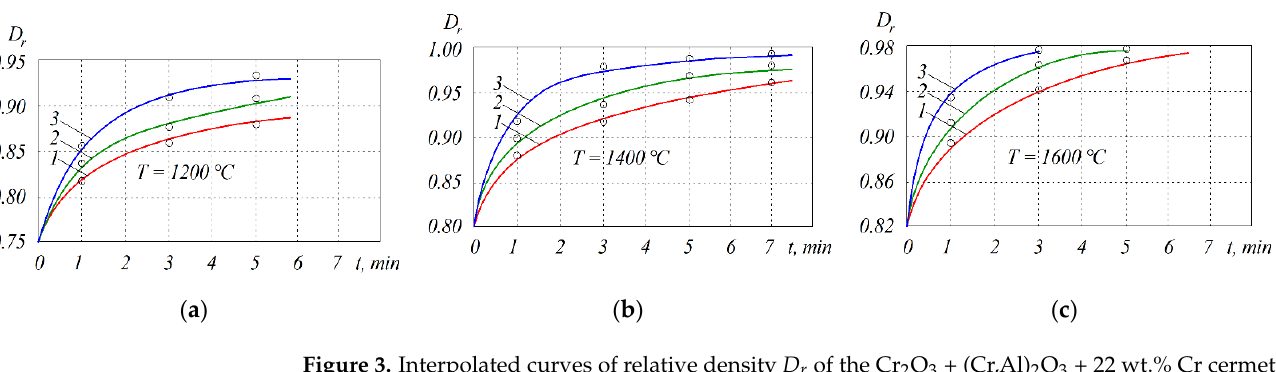
Table 2. Lattice parameters a and c for the sintered powders with different aluminum contents.